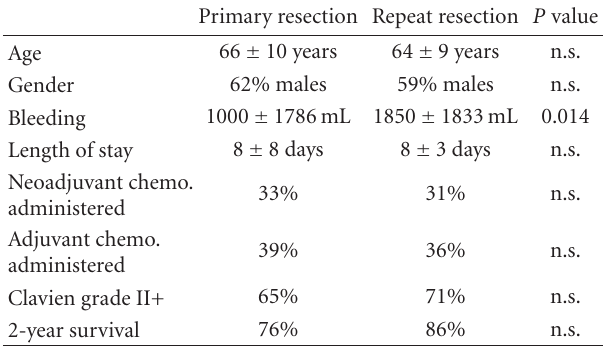
Table 1: Primary and repeated liver resection due to colorectal liver metastases—outcome